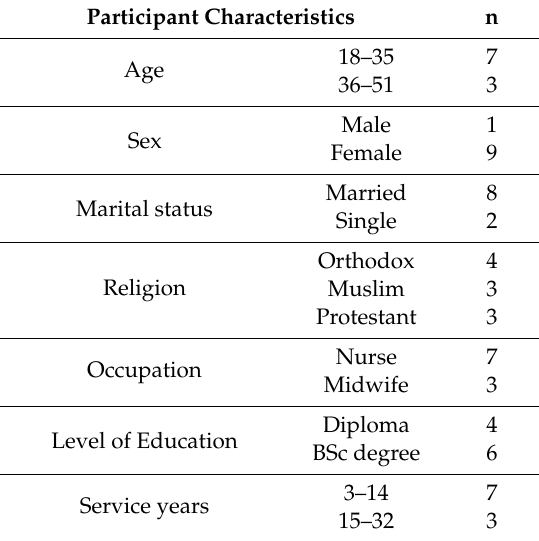
Table 1. Characteristics of the study participants (N =